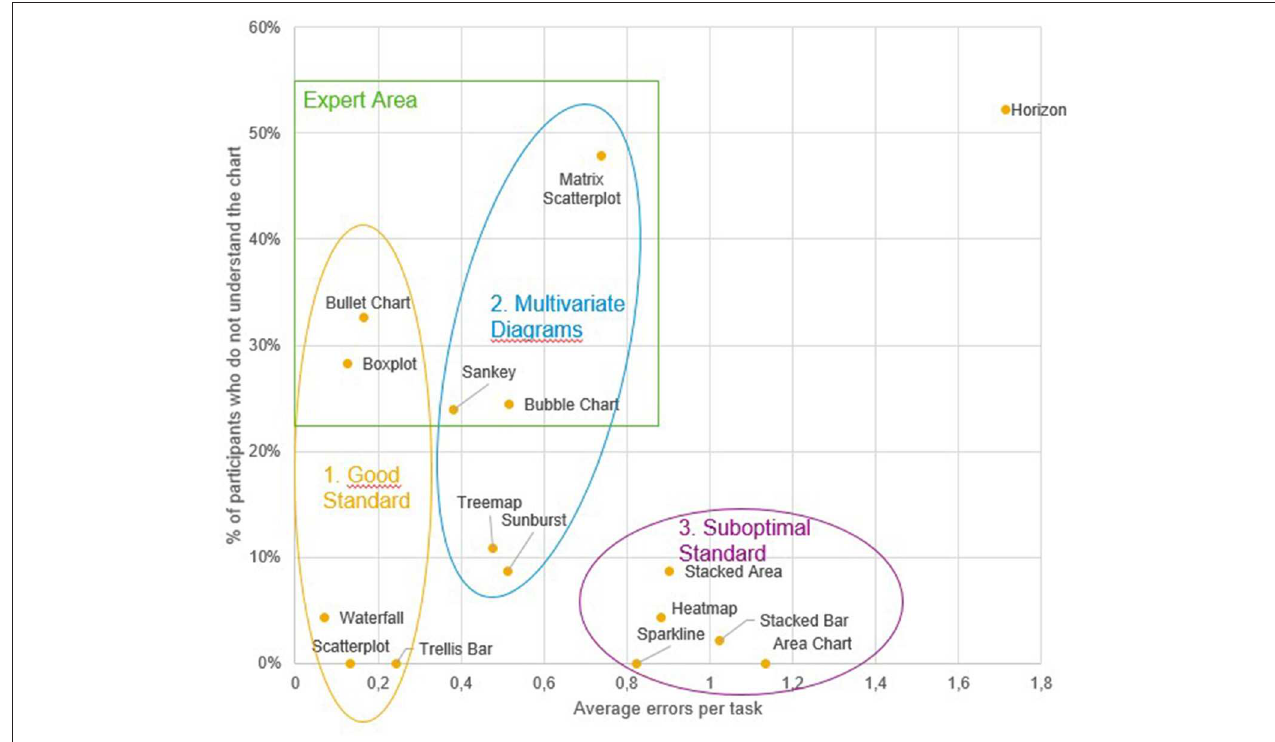
FIGURE 3 | Study 2: Scatterplot with visual representation of the emerging clusters and the artificial expert cluster.